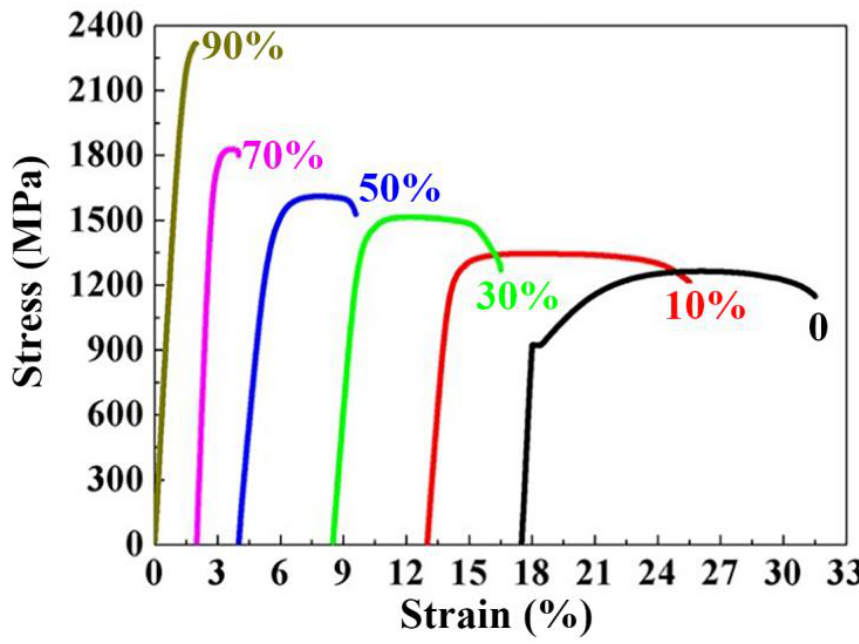
Table 2. Mechanical properties of the SK85 steel at different rolling reductions.